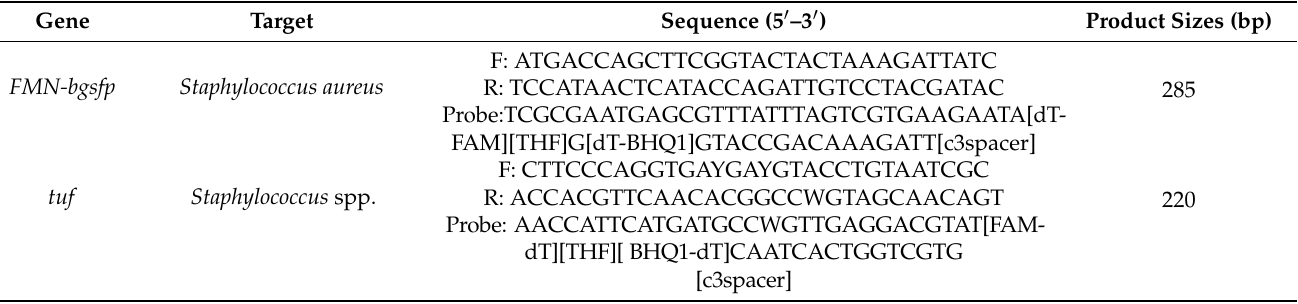
Table 1. Primers and probes